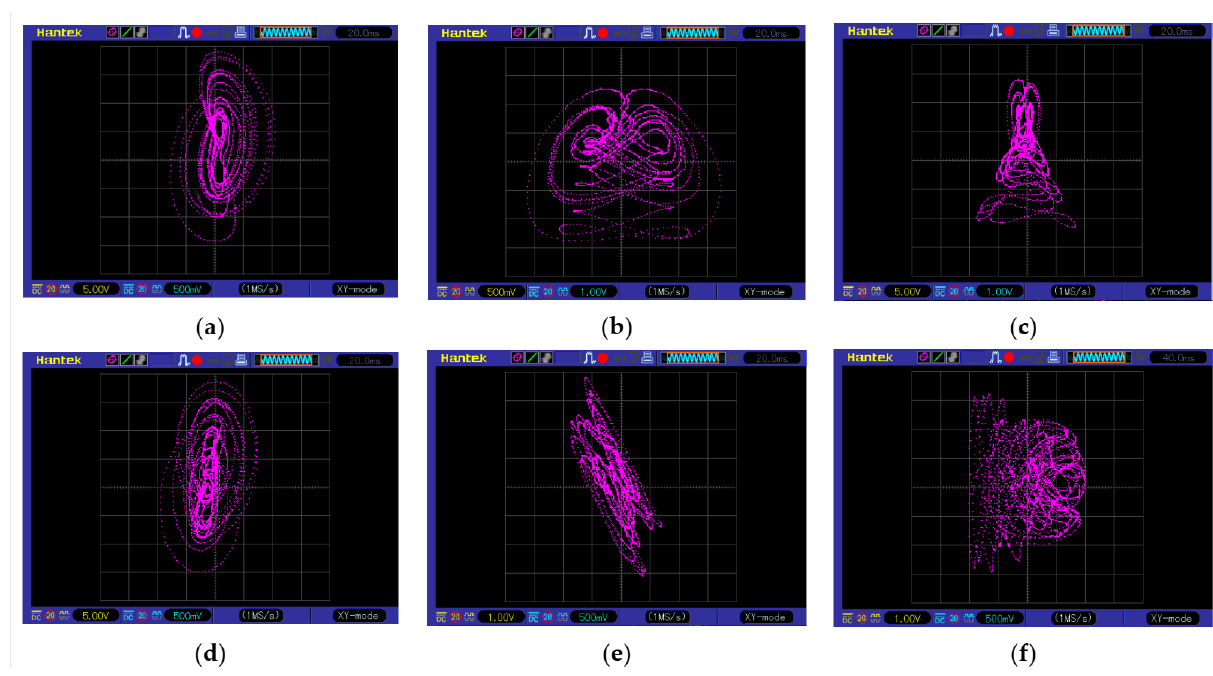
Figure 10. Electronic circuit implementation of system (11): ( a ) phase plane x ( n ) versus y ( n ) ; ( b ) phase plane x ( n ) versus z ( n ) ; ( c ) phase plane y ( n ) versus z ( n ) ; ( d ) phase plane x ( n ) versus w ( n ) ; ( e ) phase plane y ( n ) versus w ( n ) ; ( f ) phase plane z ( n ) versus w ( n ) . Table 4. Implementation results of DV-system (14) on the proposed